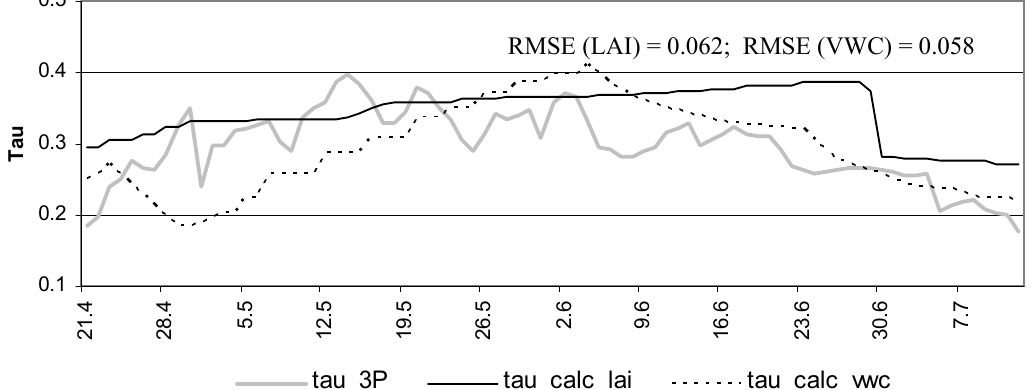
Figure 14. Comparison between calculated vegetation optical depth on the basis of water content (tau_calc_vwc) or LAI (tau_calc_lai) and tau retrieved (tau_3P).